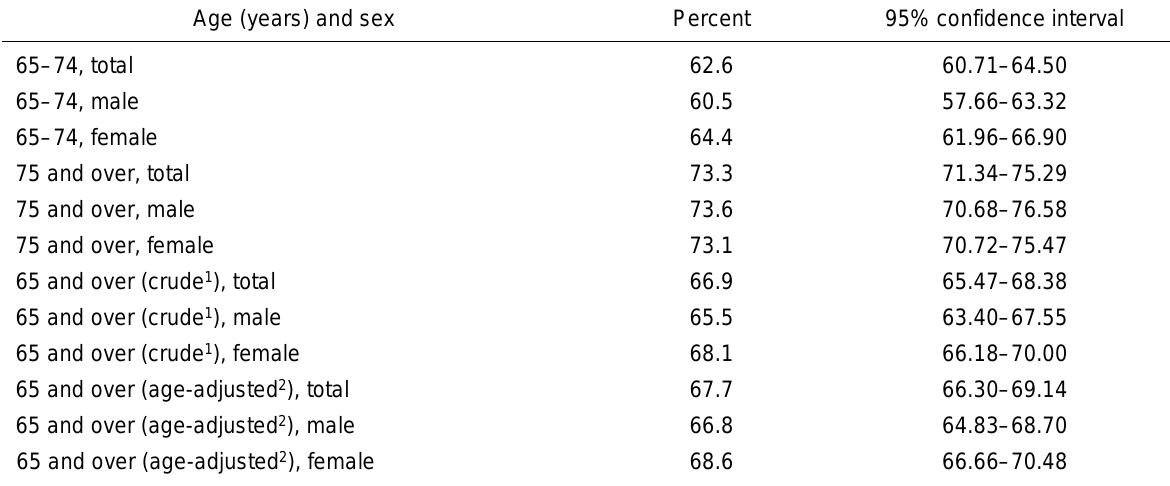
Data table for Figure 5.2. Percentage of adults aged 65 and over who had